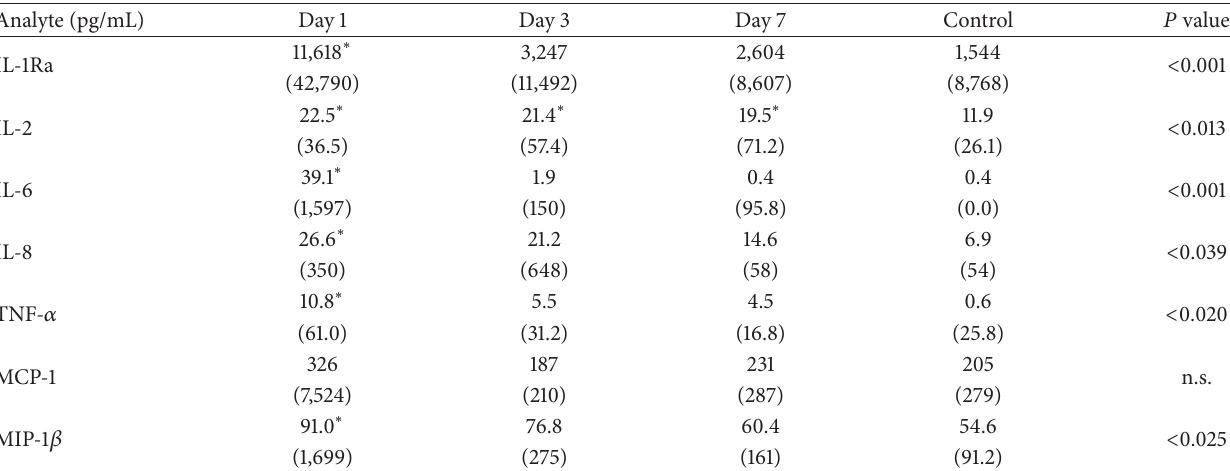
Table 4: Kinetics of inflammatory molecules in patients with bacterial infection during antibiotic